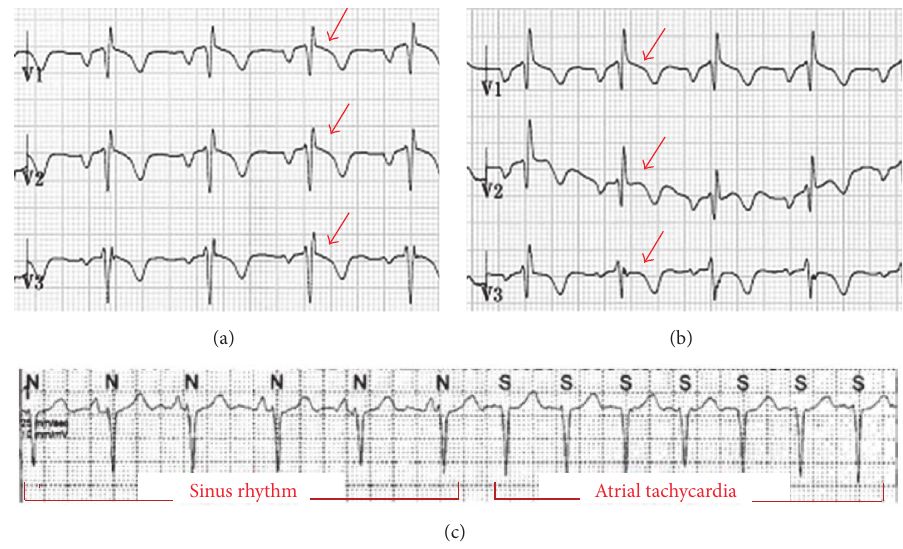
Figure 2: (a) Electrocardiogram (ECG) shows an rSR’ pattern with ST-segment elevation (red arrows) and T-wave inversion on the right precordial leads, indicating a Brugada-like ECG pattern. (b) Six months after Nuss operation even though ST-segment elevation is not fully . (c) Atrial tachycardia was documented on twenty-four-hour ambulatory Holter recovered on lead V 1 , it seems to be normalized on lead V 2 - 3 monitoring before the